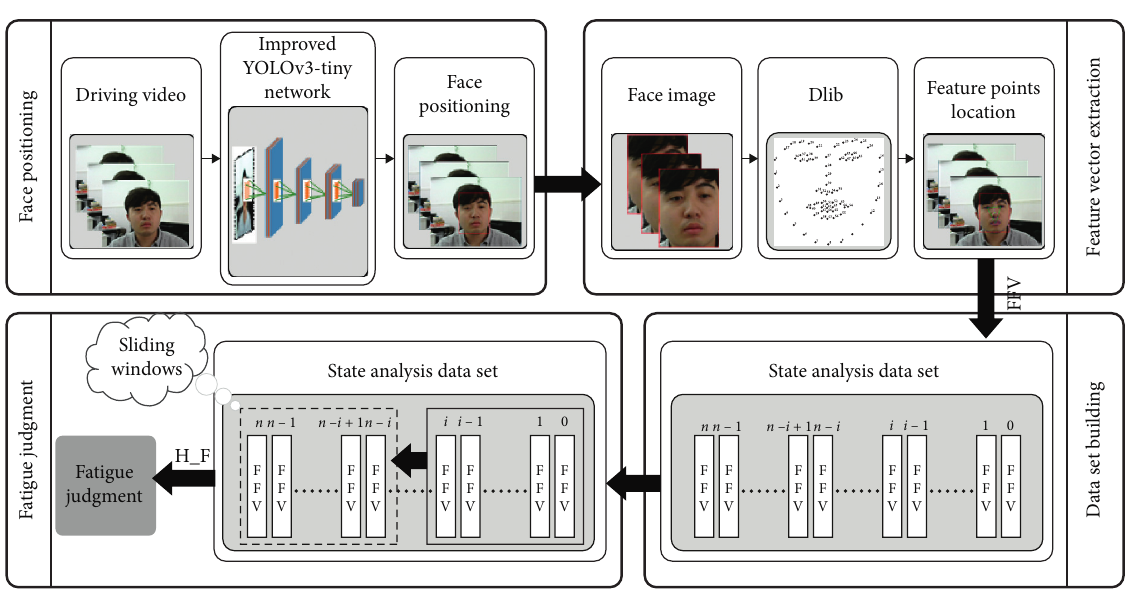
Figure 1: Algorithm structure diagram, where H_F is facial motion information entropy.